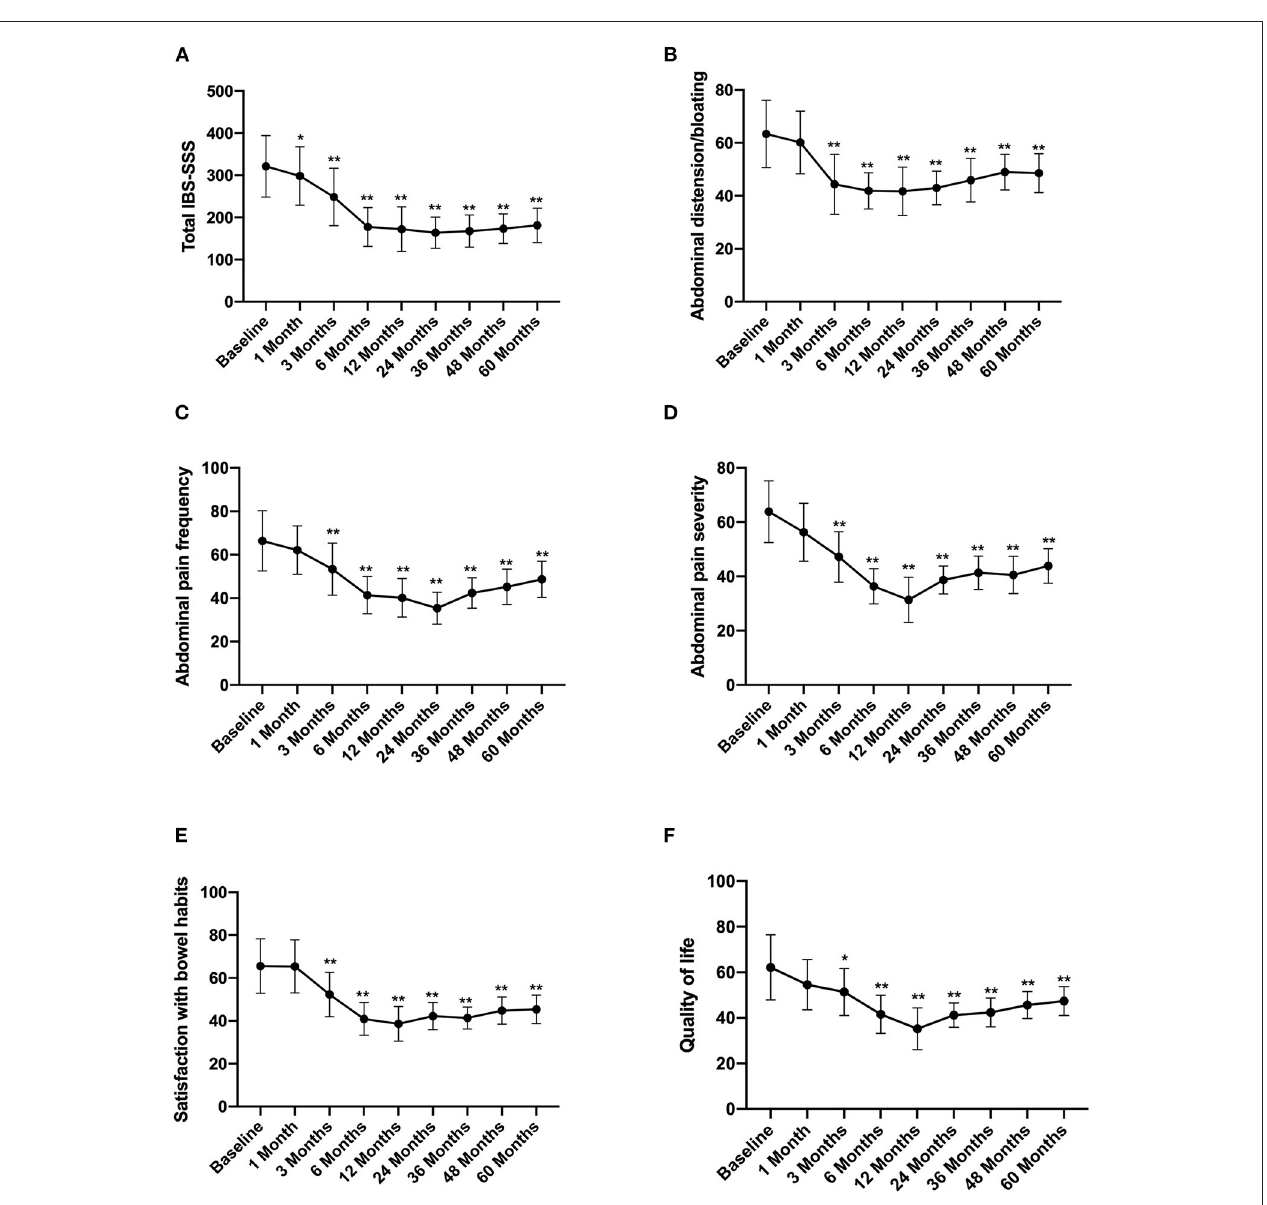
FIGURE 2 | IBS-SSS score between groups and the change over time. Difference was compared between each time point of follow-up and before FMT (baseline). (A) Total IBS-SSS score; (B) abdominal distension/bloating score; (C) abdominal pain frequency score; (D) abdominal pain severity score; (E) satisfaction with bowel habits score; (F) quality of life score. IBS-SSS, IBS severity scoring system. Data are presented as x ± s , statistical analyses: univariate analysis of variance, * p < 0.05, ** p < 0.01. and 17 (44.74%), 24 (70.59%), 10 (52.63%), and 2 (40.00%)